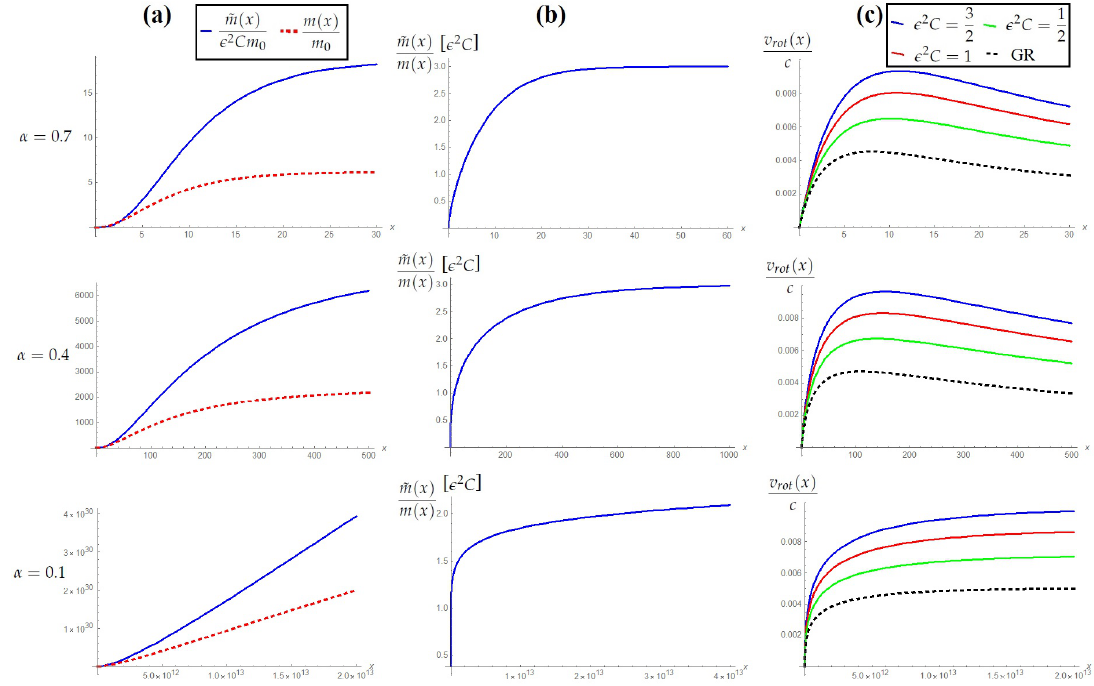
Figure 3. Einasto Profile Calculation for α = { 0.7,0.4,0.1 } . ( a ) ordinary and δ Matter vs. normalized